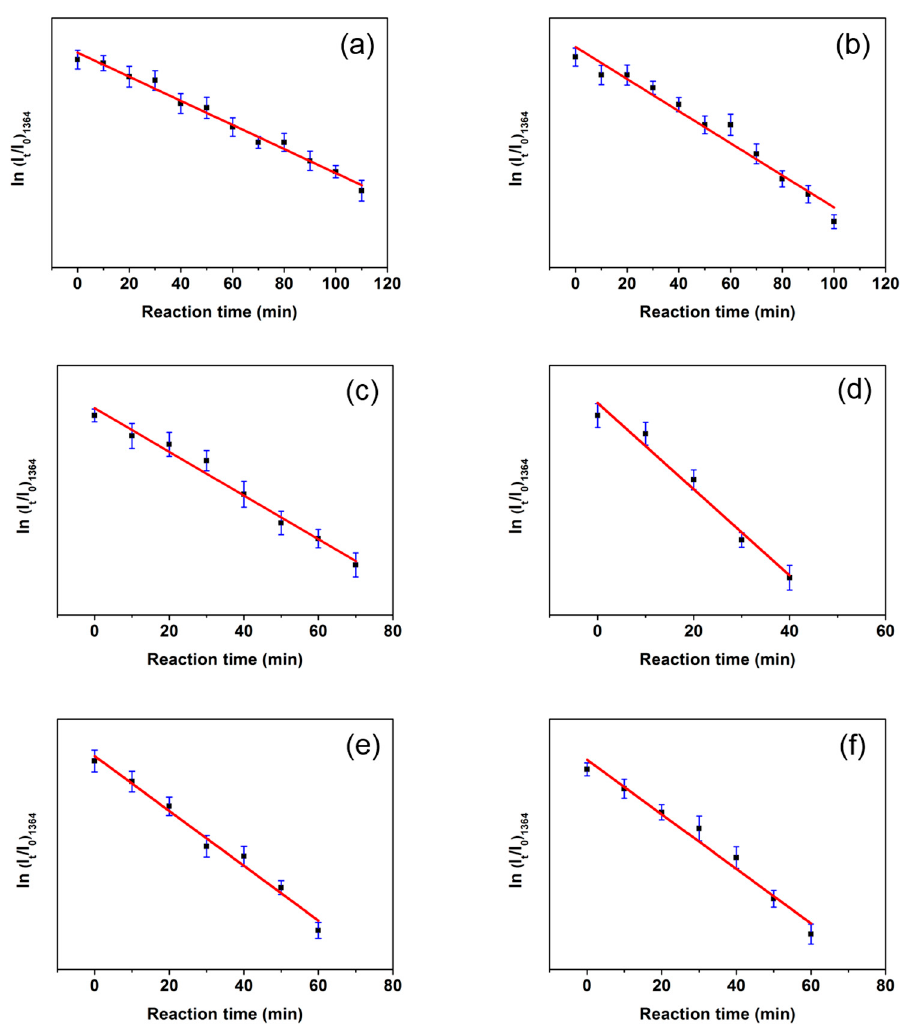
Figure A2. SEM images of substrates with different silver nanoparticle deposition times: ( a ) 2 h, ( b ) 4 h, ( c ) 6 h, ( d ) 8 h, ( e ) 10 h, and ( f ) 12 h.